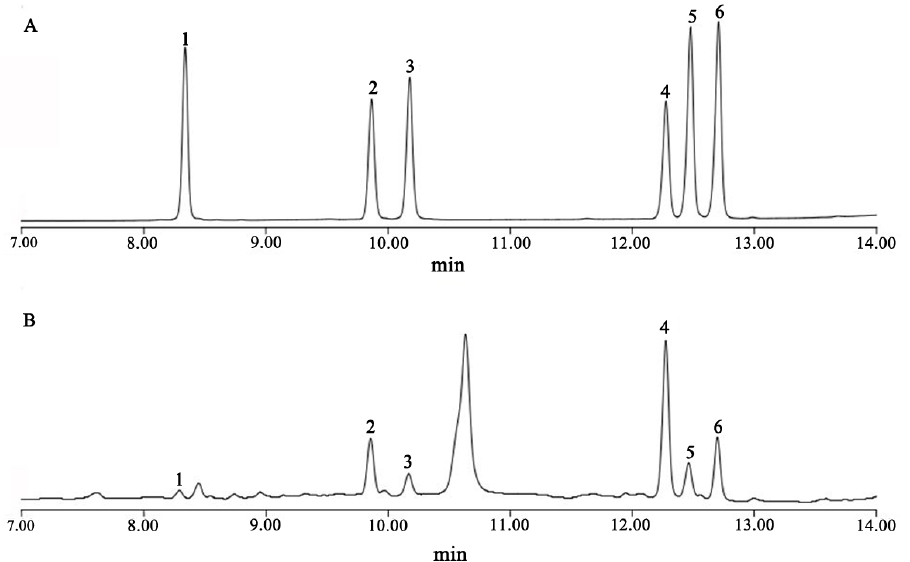
Figure 5. Ultra-performance liquid chromatography diagram of the steroidal saponins of Paris polyphylla var. yunnanensis . ( A ) Control chromatogram; ( B ) Paris polyphylla var. yunnanensis chromatogram: 1. pseudoprotodioscin; 2. polyphyllin VII; 3. polyphyllin H; 4. polyphyllin II; 5. dioscin; and 6. polyphyllin I.